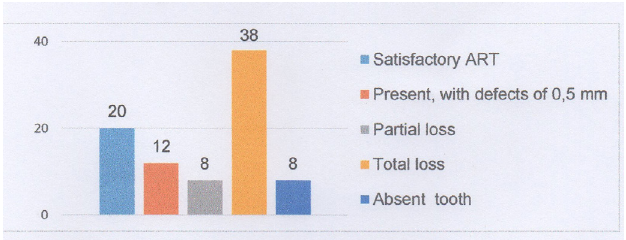
Fig. 3 - Evaluation criteria of ART control. Parnaíba-PI.